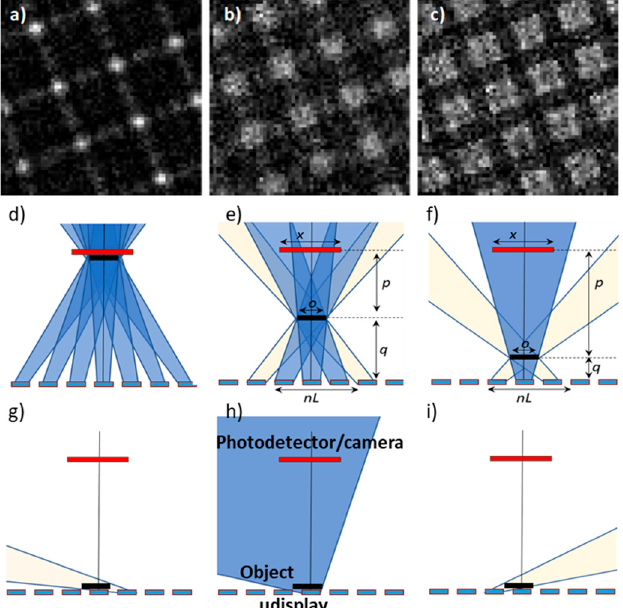
Figure 4. Static images of a squared TEM grid located 4 ( a ), 2 ( b ) and 1 ( c ) mm above source 1 , in an observation chamber around 10 mm high (i.e., a fixed position of the detector 10 mm away from the display). Schemes of shadows generated by the central LED and its neighbors for different sample heights in ( d – f ). The detector senses shadows coming from a larger number of neighbors as the sample is higher, deteriorating the image accuracy. In ( g – i ) the case when the sample is in contact with the microdisplay is shown.